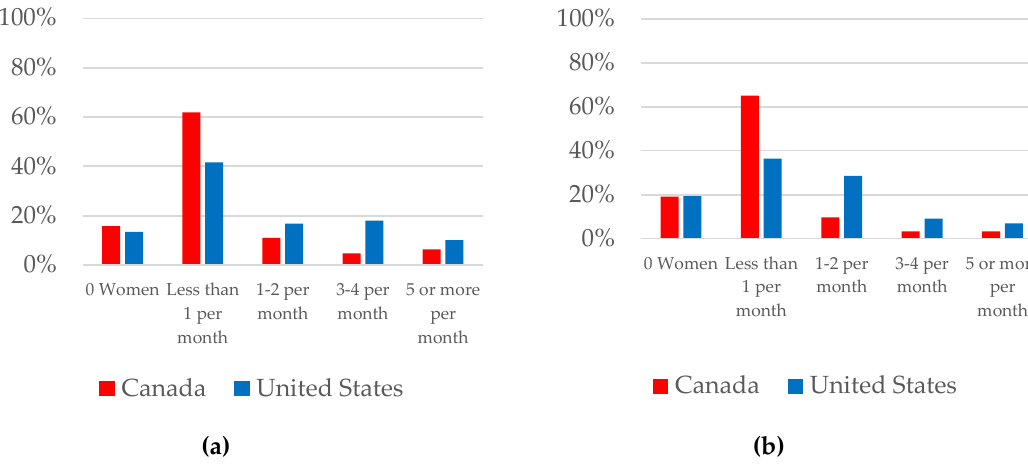
Figure 3. Average frequency of counseling provided by survey respondents in the areas of ( a ) contraception/family planning and ( b )